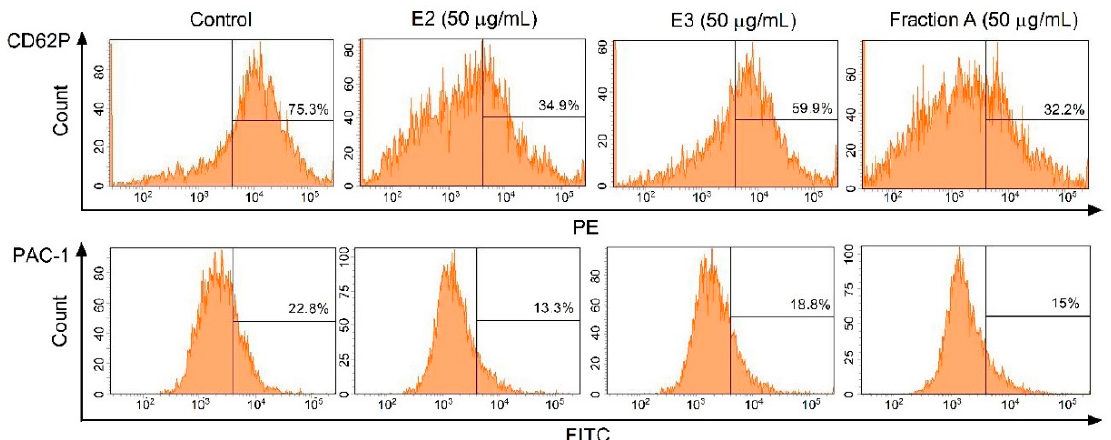
Figure 11. Effects of dandelion fruit preparations (E2, E3, and fraction A; concentration 50 µg/mL) on the expression of P-selectin and the active form of GPIIb/IIIa in platelets stimulated by 10 µg/mL collagen in whole blood samples. Figure demonstrates selected diagrams. None of the dandelion fruit preparations changed the APTT, PT, TT, or AUC 10 values measured by T-TAS for either human plasma or whole blood (Figure 12, Table 4).